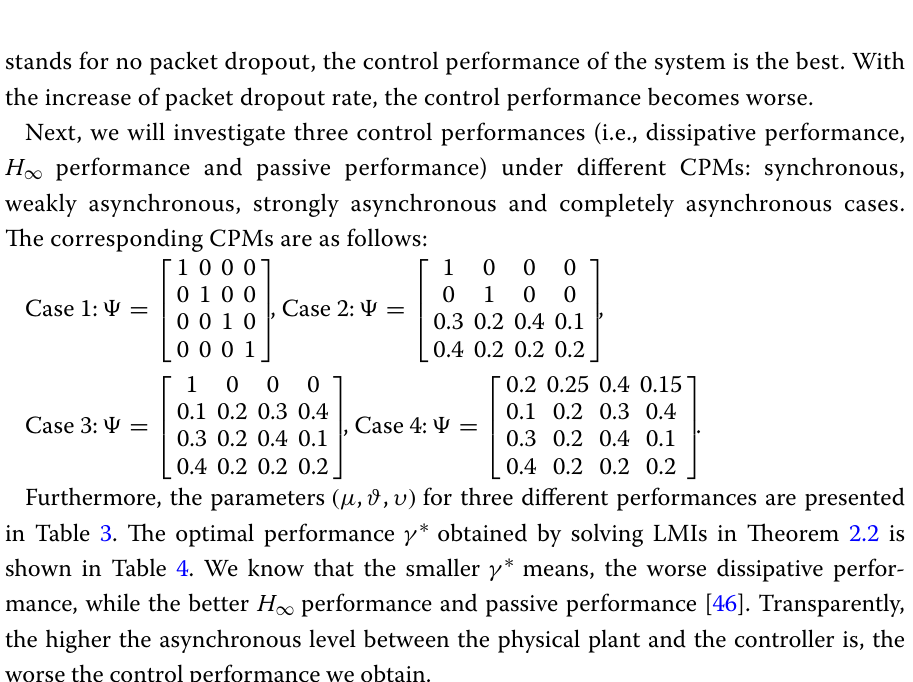
Table 4 The values of optimal performance γ ∗ under different performances γ